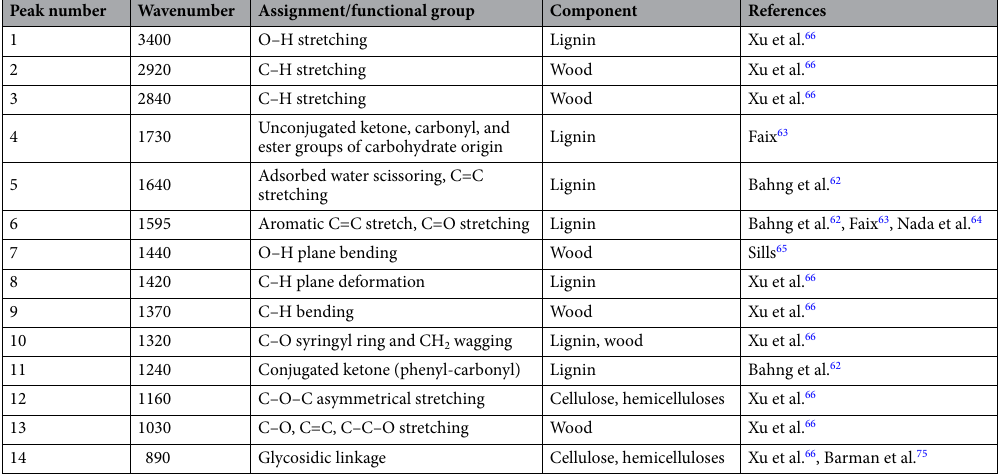
Table 7. Band assignments for infrared spectra. Wavenumber is given as cm -1